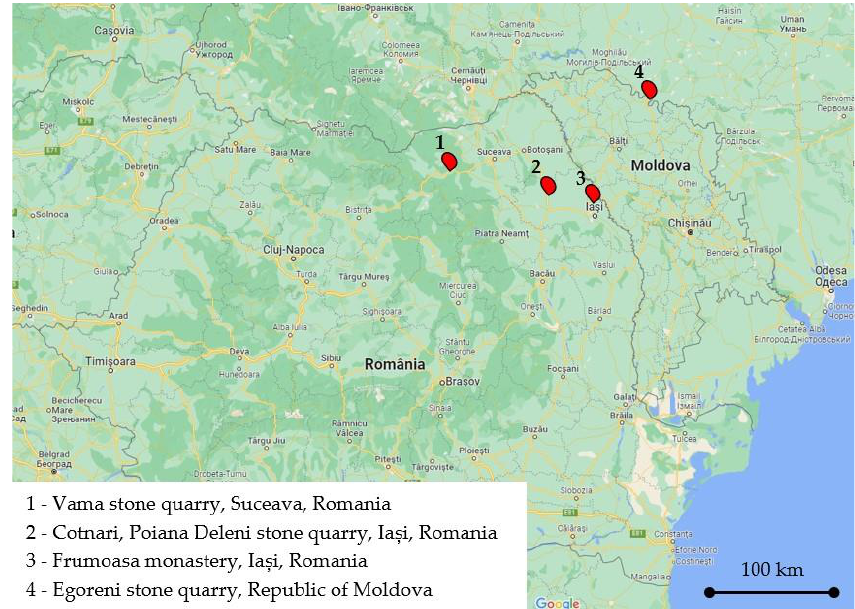
Figure 2. The location of Frumoasa monastery and the samples extracted as possible source materials for the reconstruction process. Adapted from Google Maps [14].